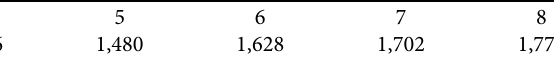
Table 2: The load data.